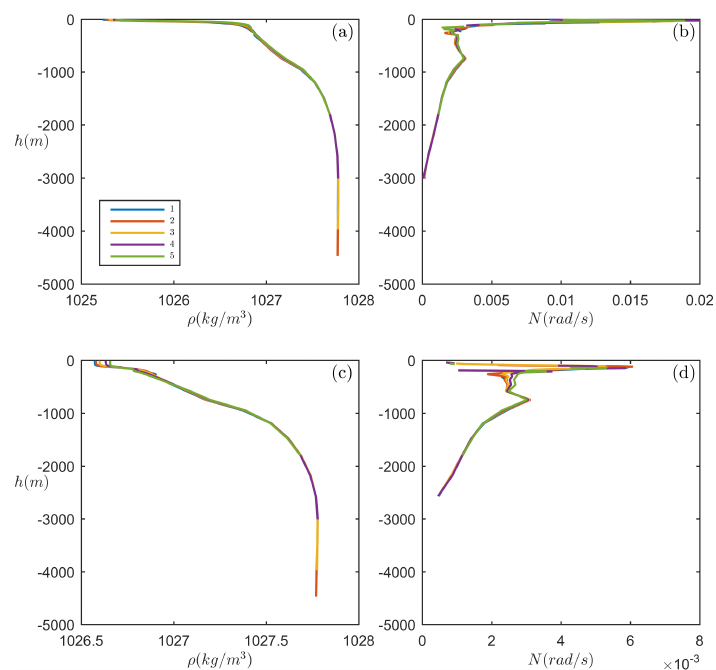
Figure 2. Background density and buoyancy frequency distribution along the transect of the Western Portugal case. ( a , b ) are situations in summer, while ( c , d ) are in winter. Five different lines in each panel represent situations on the chosen five points along the wave propagation transect.